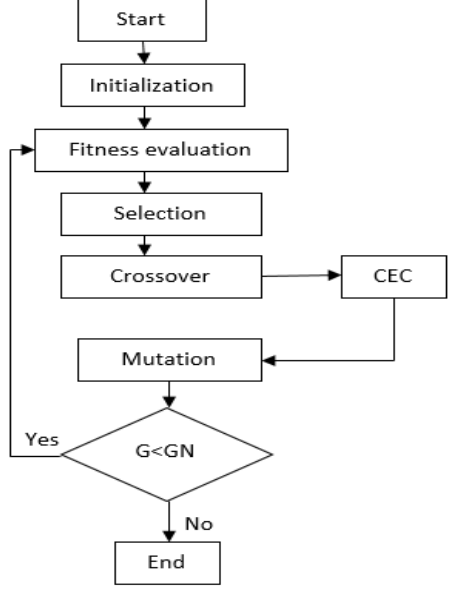
Figure 4. Block diagram of CECGA.